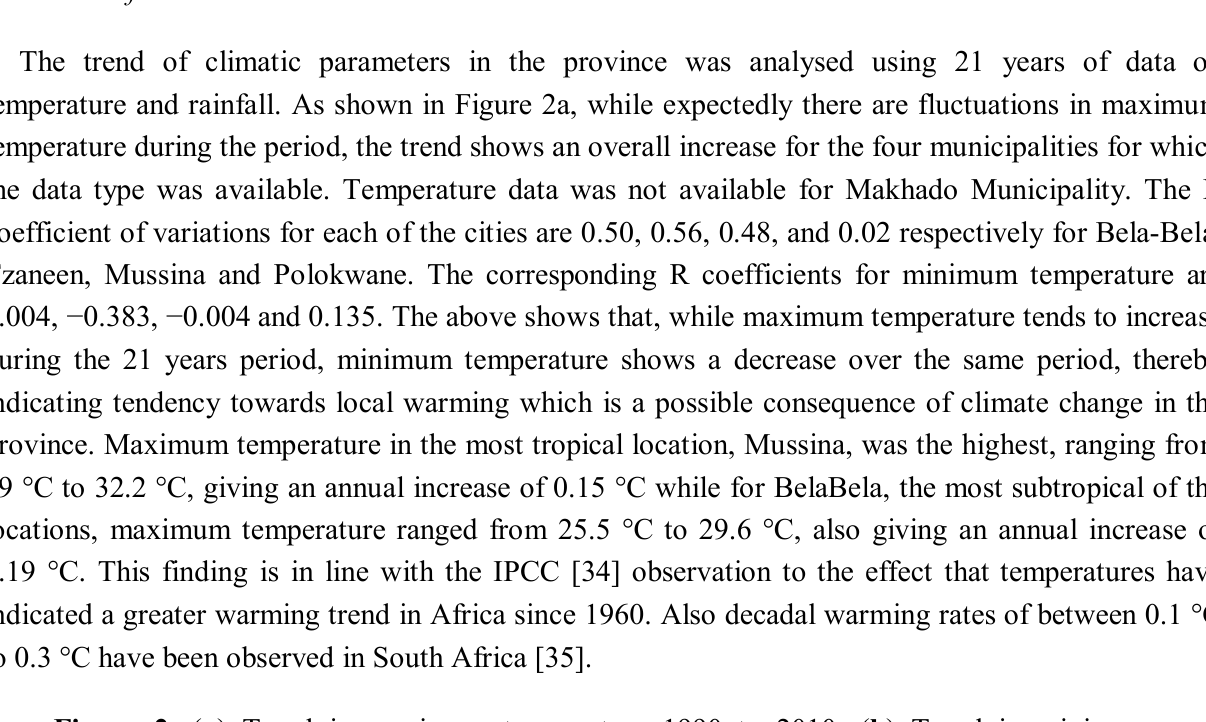
Figure 2. ( a ) Trend in maximum temperature 1990 to 2010; ( b ) Trend in minimum temperature 1990 to